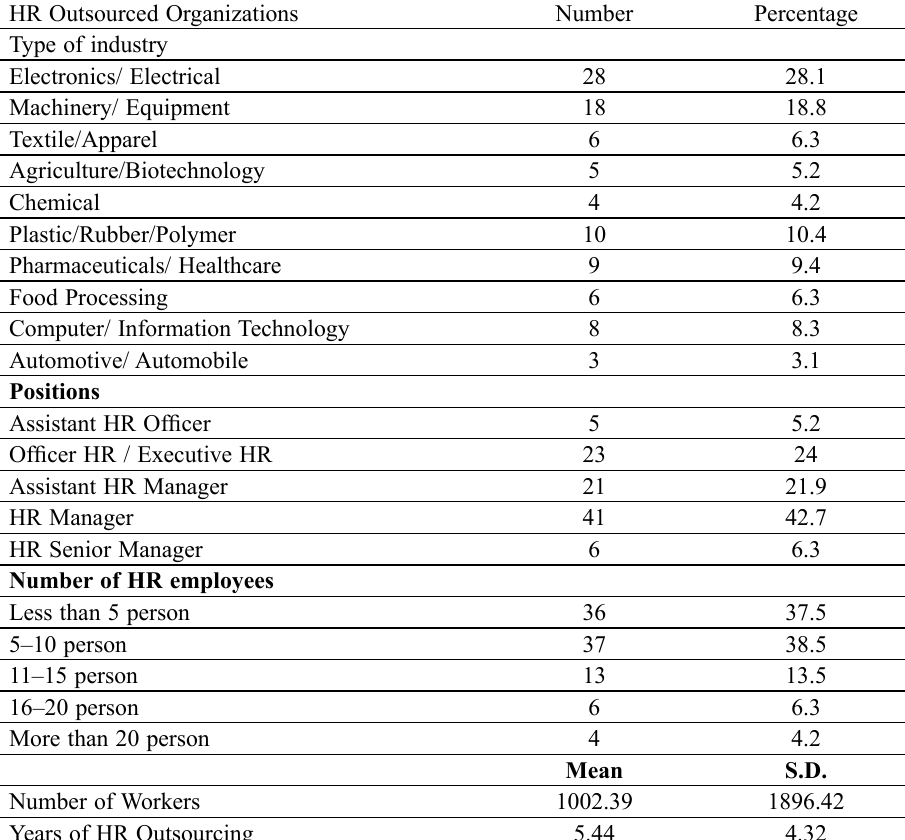
Table 1. Profile of the organizations that outsourced HR